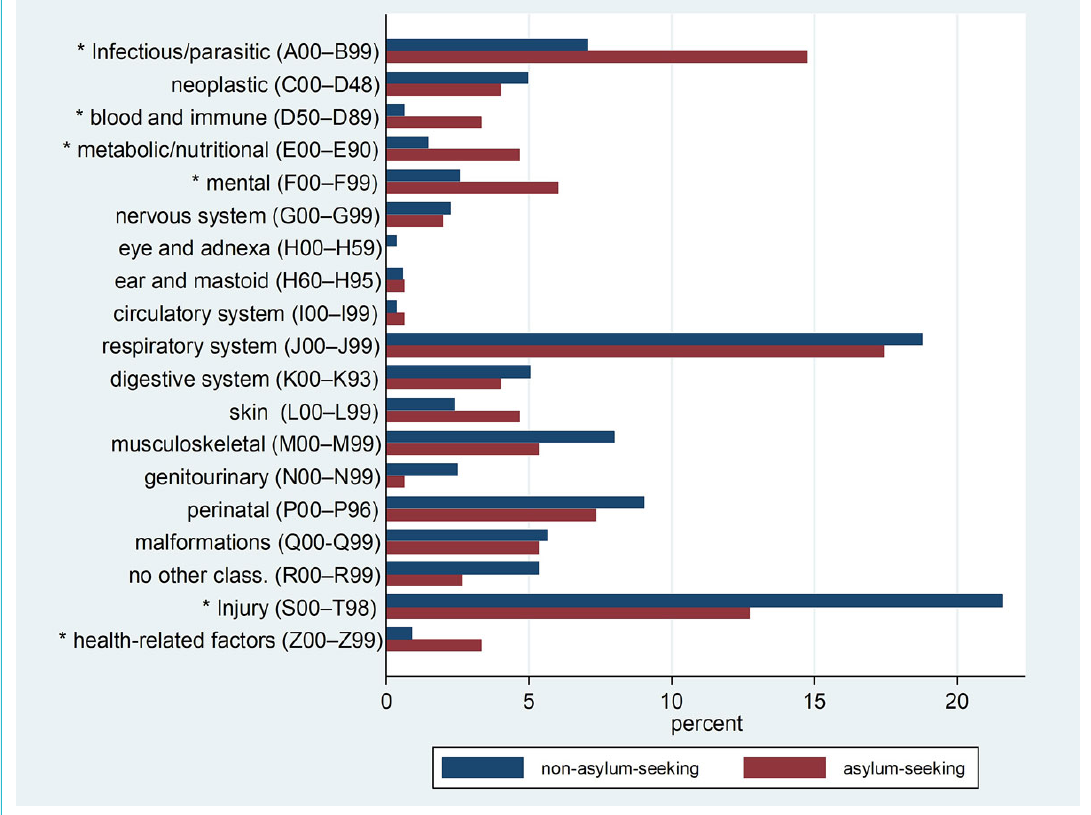
Figure 3: Proportion of main admission diagnosis according to the international disease classification (ICD) 10 for the non-asylum-seeking children (blue bars) and the asylum-seeking children (red bars).* p-value < 0.05